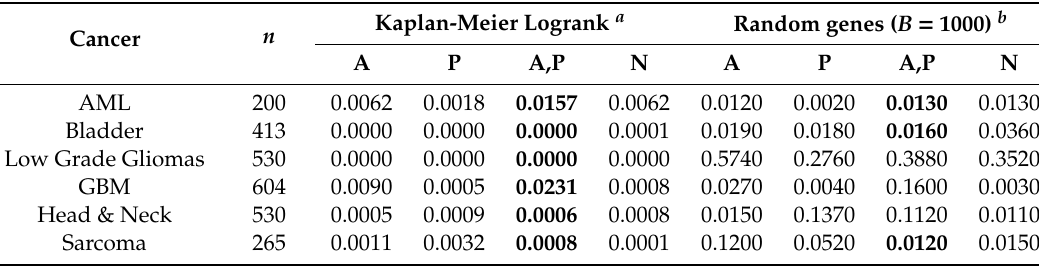
Table 2. Kaplan-Meier (KM) logrank test p -values for best principal component (best binarized PC) derived from correlation matrix of DNA repair genes with significant individual KM tests after adjustment of expression for age and PCNA metagene e ff ects. Cancers listed had only age at diagnosis available in TCGA clinical